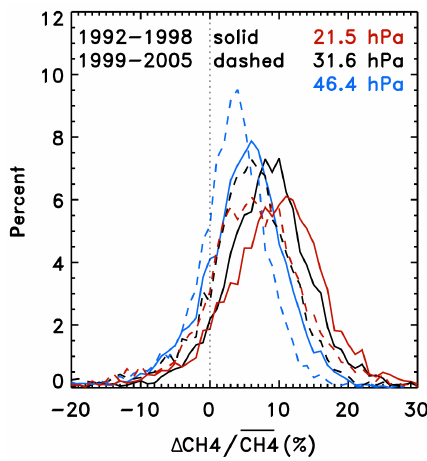
Figure 9. Histograms of percentage differences between HALOE and simulated CH 4 at 46.4hPa (blue), 31.6hPa (black) and 21.4hPa (red) for all HALOE profiles between 35 and 55 ◦ . The distribu- tions at all levels shift towards better agreement with observations for 1999–2005 compared with 1992–1998.